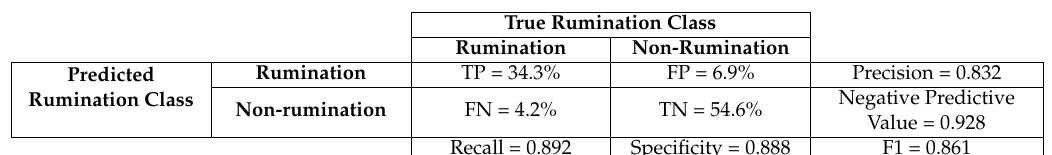
Table 1. The confusion matrix for the classification of rumination by the Support Vector Machine (SVM) model with collar validation.